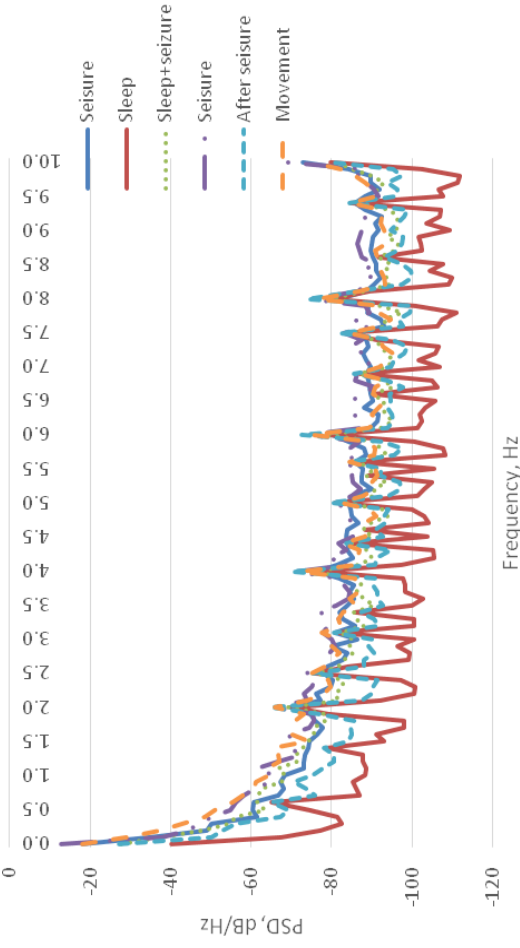
Figure 1 . Optical flow periodograms of recordings of various events for one of the patients computed at window size W = 600.